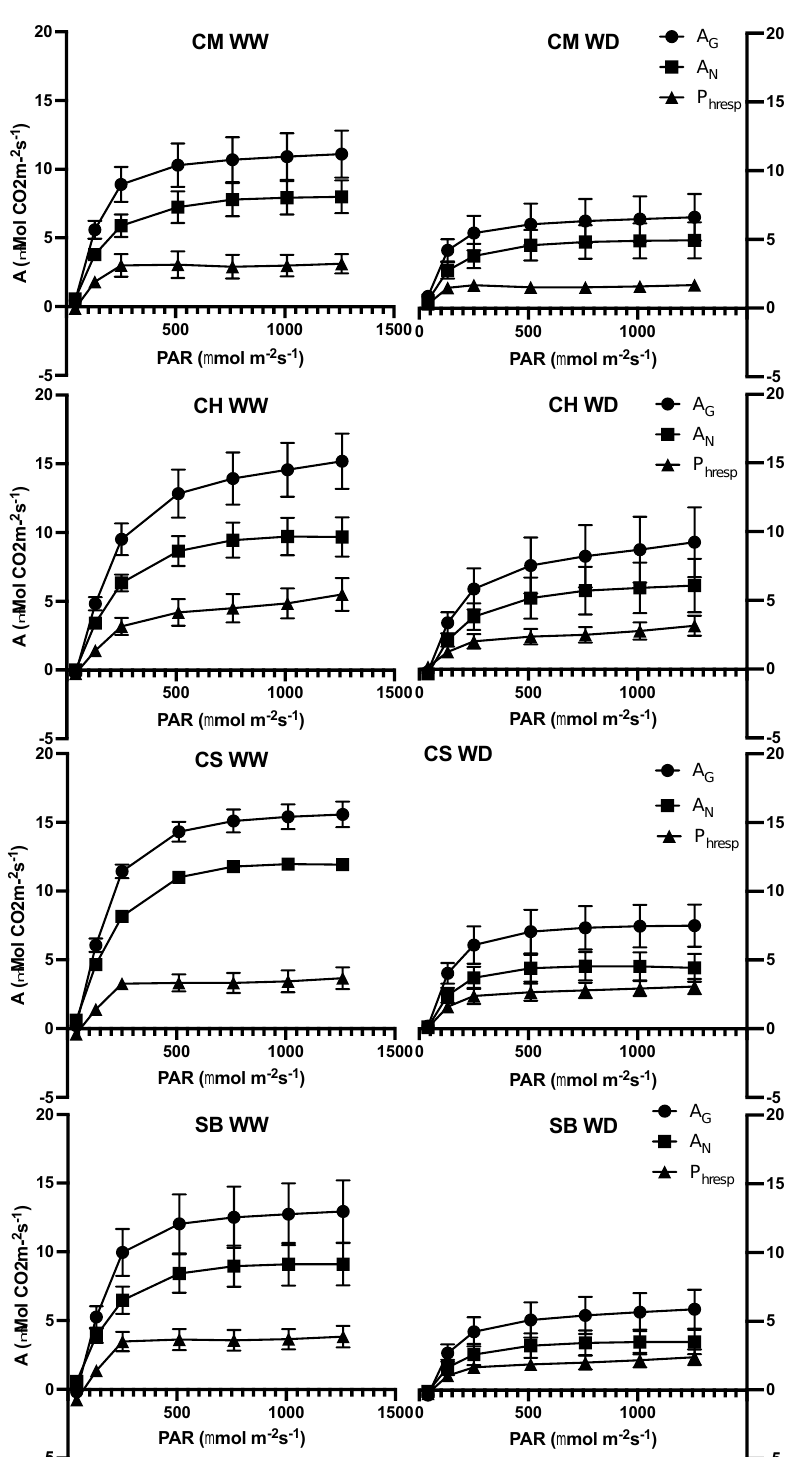
Figure 5. Gross net CO 2 assimilation: AG; net CO 2 assimilation: AN and photorespiration: Phresp responses to light intensities for Carmenere (CM), Chardonnay (CH), Cabernet sauvignon (CS) and Sauvignon blanc (SB) for WW (right figures) and WD (left figures). Error bars represent SE. Single asterisk represents significant differences between treatments for each variety p ≤ 0.05. Double asterisk represents significant differences between treatments for each variety p ≤ 0.01.